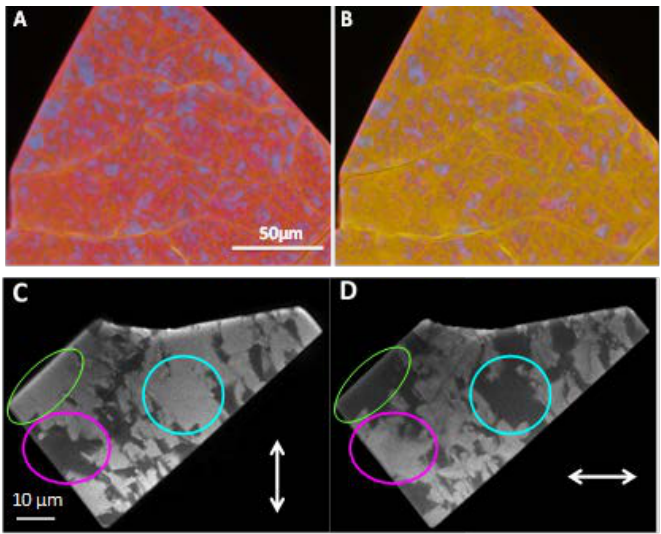
Figure 4. Fluorescence image of a MOF big crystal previously immersed in toluene and iodobenzene, ( A ) just after the addition of anisole, and ( B ) 10 min later. ( C , D ) Polarization images of a PCP crystal immersed in toluene under 410 nm excitation. White arrows indicate the direction of the polarizers. Circles highlight domains with complementary response to linear polarized light.